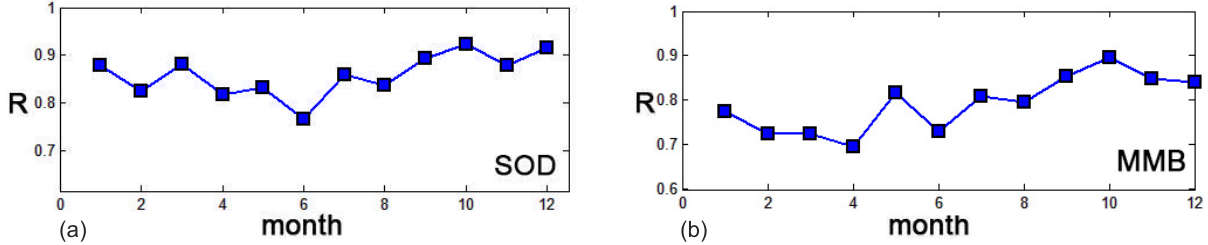
Figure 4. Seasonal change of the correlation coefficient R between K index and MA in 2003 at SOD observatory (a) and MMB observatory